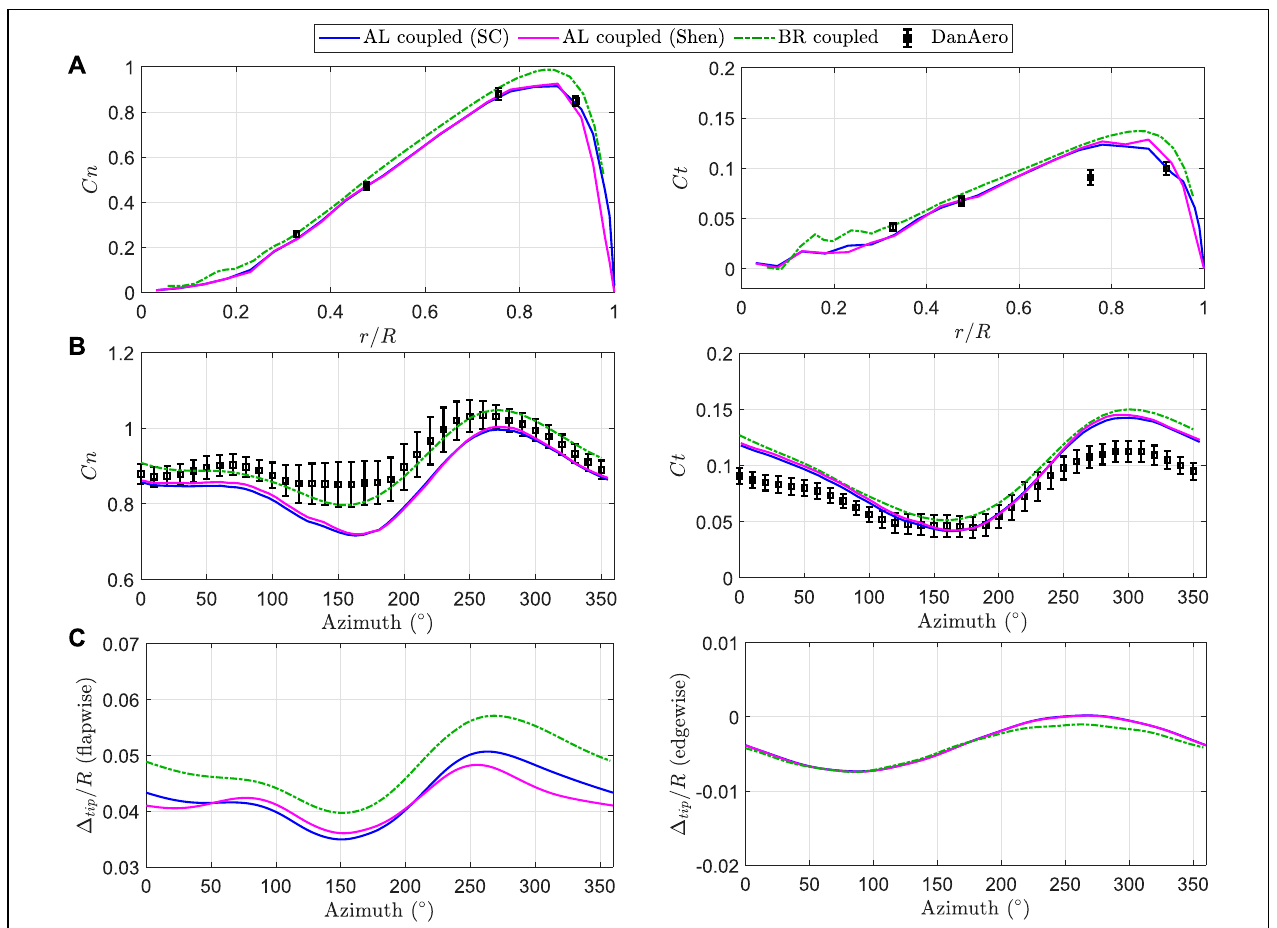
FIGURE 7 | Case 3: high shear and high yaw. (A) Normalised normal and tangential blade loads distribution at 0 ° azimuth; (B) Normalised normal and tangential blade loads at 75% radius; (C) Normalised flapwise and edgewise tip